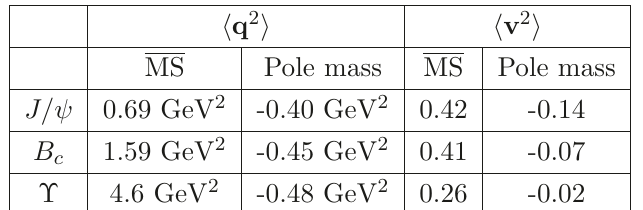
q 2 v 2 and using the running quark masses in the MS scheme and pole masses. h i h i